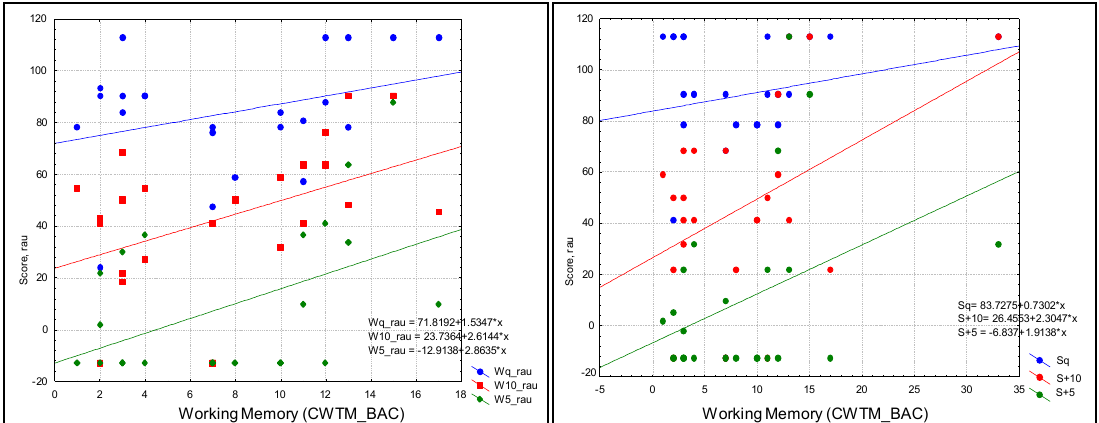
Figure 3. Scatterplot of audiological outcomes. Left: words in three conditions (blue = quiet (Wq), red = SNR = +10 (W+10), and green = SNR+5 (W+5)). Right: sentences in three conditions (blue = quiet (Sq), green = SNR = +10 (S+10), red = SNR+5 (S+5)) as predicted by WM in the study sample; scatterplots were produced without the contribution of outliers in the analysis: W+10 (R = 0.43, R 2 = 0.19; p = 0.031) and W+5 (R = 0.47, R 2 = 0.224; p = 0.019).